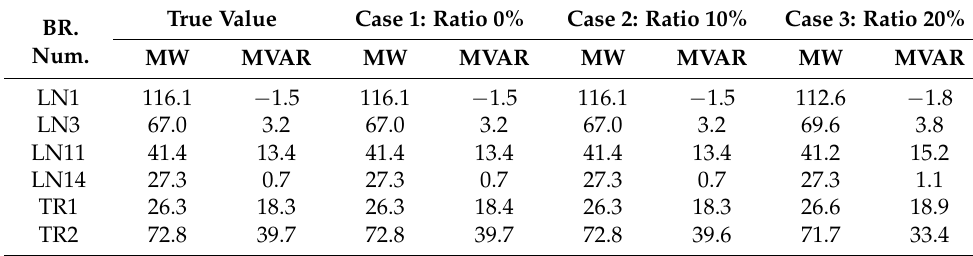
Table 7. Estimated branch flow for Scenario